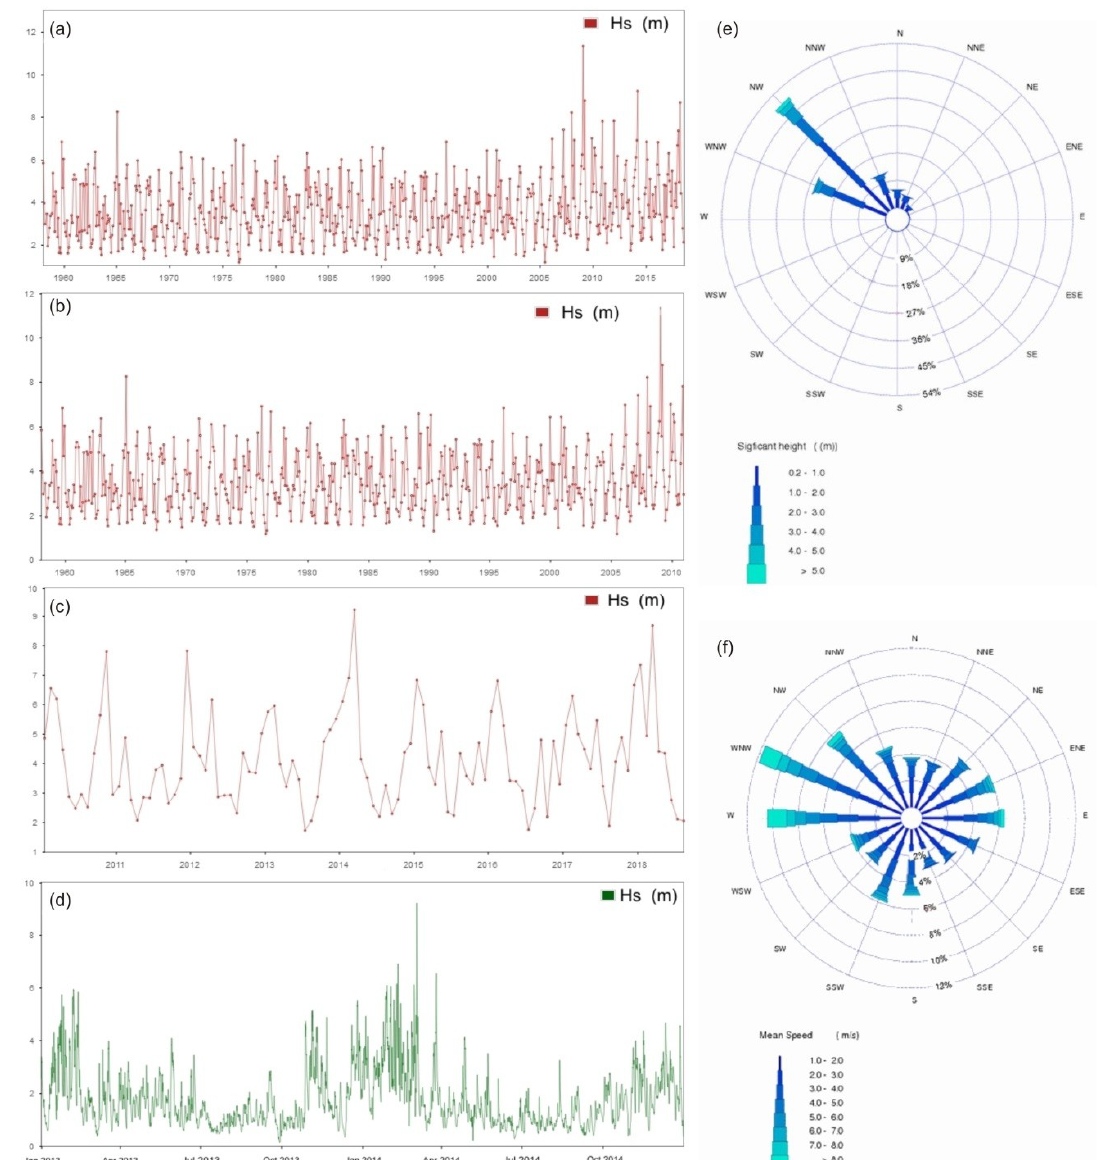
Figure 2. Maritime climate in the Cantabrian region. Significant wave height historical record (maximum monthly value) for the entire time period of analysis ( a ), pre-storm period ( b ) and post-storm period ( c ). Significant hourly wave height for the 2013–14 winter storms ( d ). Significant wave height incident direction ( e ) and wind direction and magnitude ( f ). All data available from http://www.puertos.es/es-es/oceanografia/Paginas/portus.aspx.